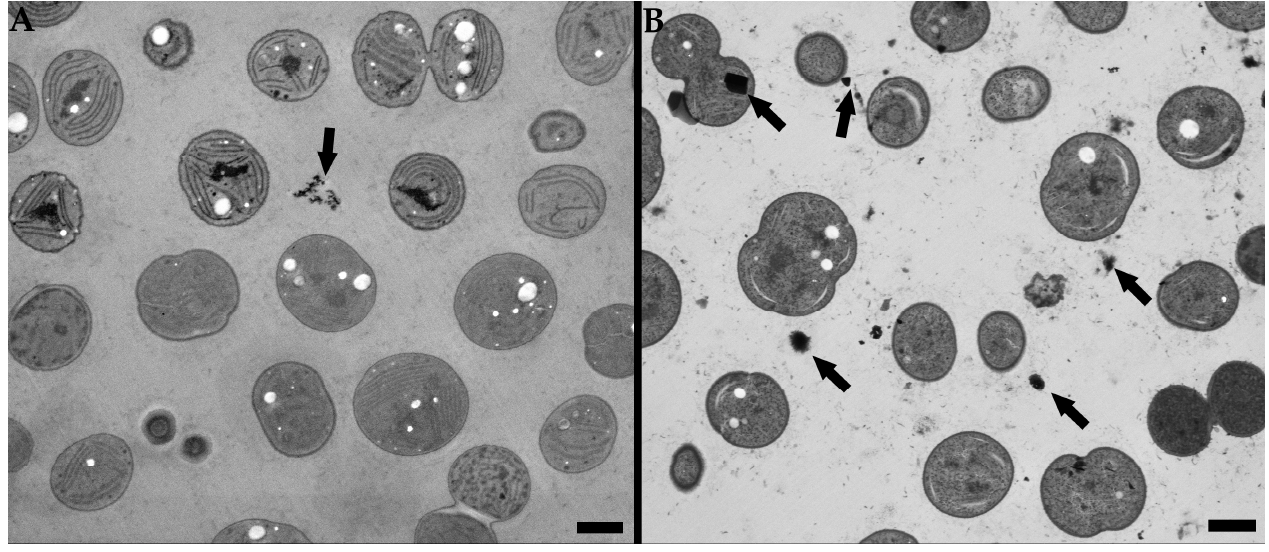
Figure 7. Cyanobacterial cells were imaged using SEM equipped with a STEM detector with a 15 kV accelerating voltage electron beam. ( A ) Unstained sample, ( B ) sample stained using uranyl acetate and lead citrate. Impurities marked by arrow. Scale bar: 1 µ